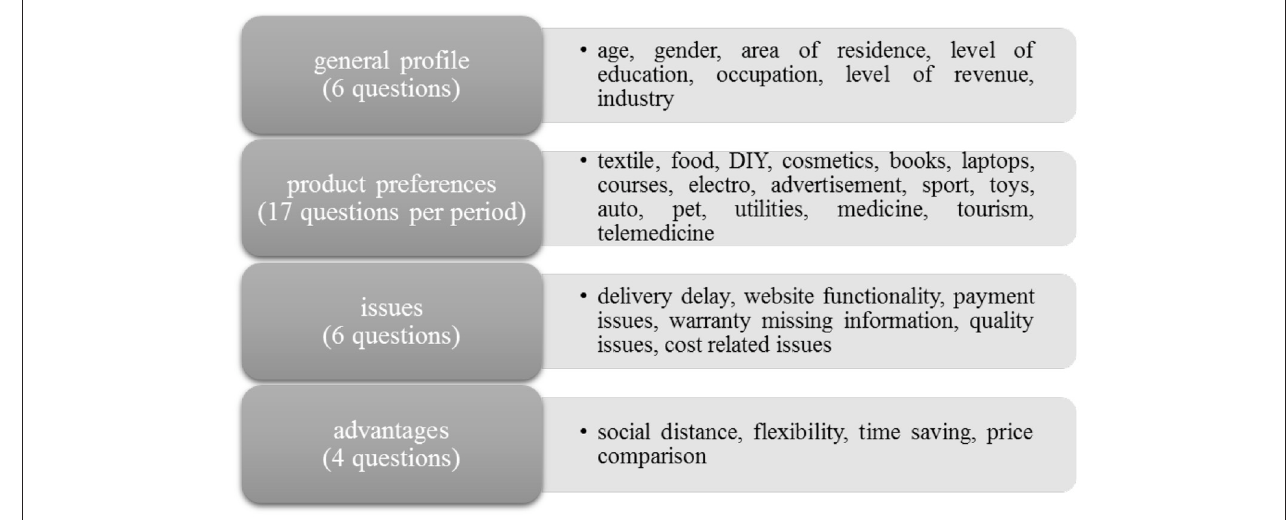
FIGURE 2 | Topics addressed within the questionnaire disseminated. Source: authors’